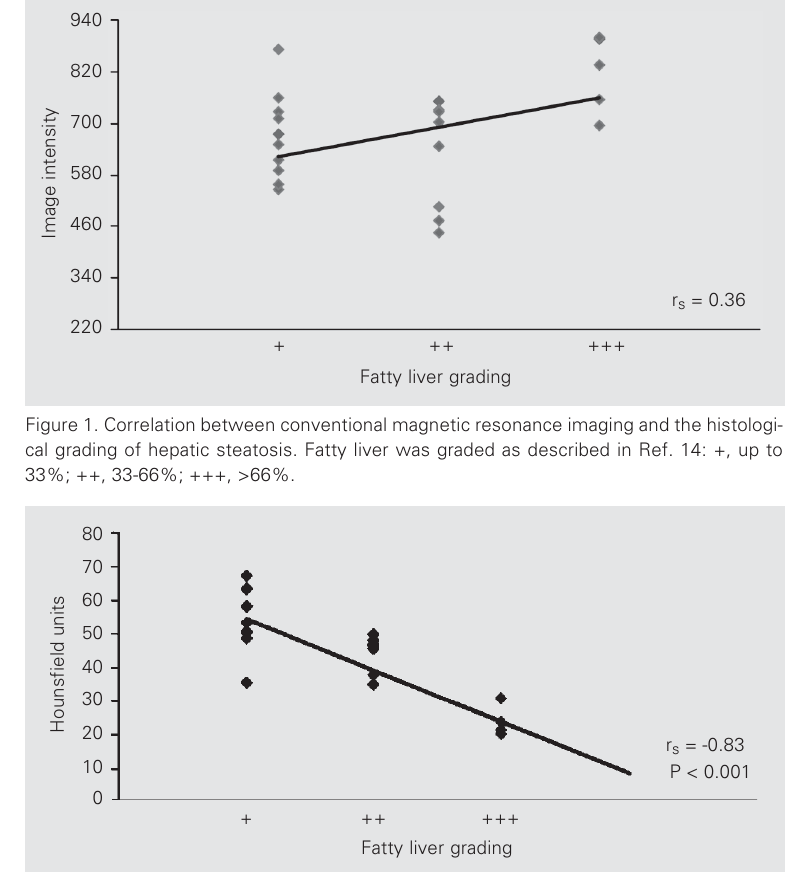
Data are reported as means ± SEM for 15 patients in each group. ALT and AST: alanine and aspartate aminotransferase, respectively; BMI: body mass index; γ -GT: γ -glutamyl- transferase; NAFLD: nonalcoholic fatty liver disease scored as described in Ref. 1; UDCA: ursodeoxycholic acid. No statistical differences were found for histological or clinical data between groups.